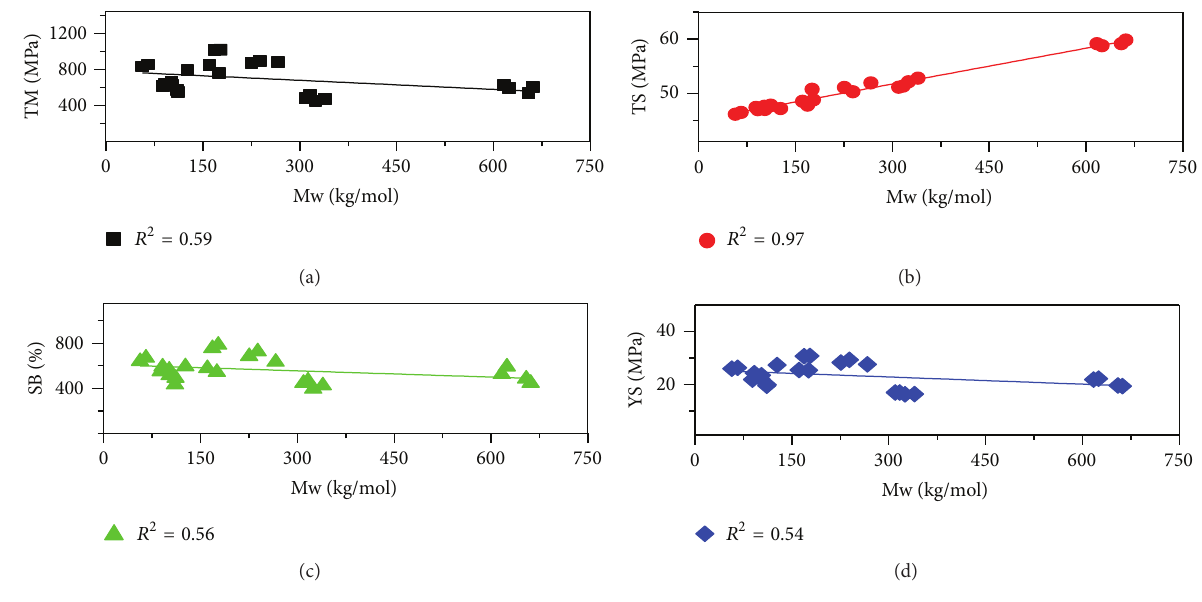
Figure 7: Correlation of Mw with (a) TM, (b) TS, (c) SB, and (d)